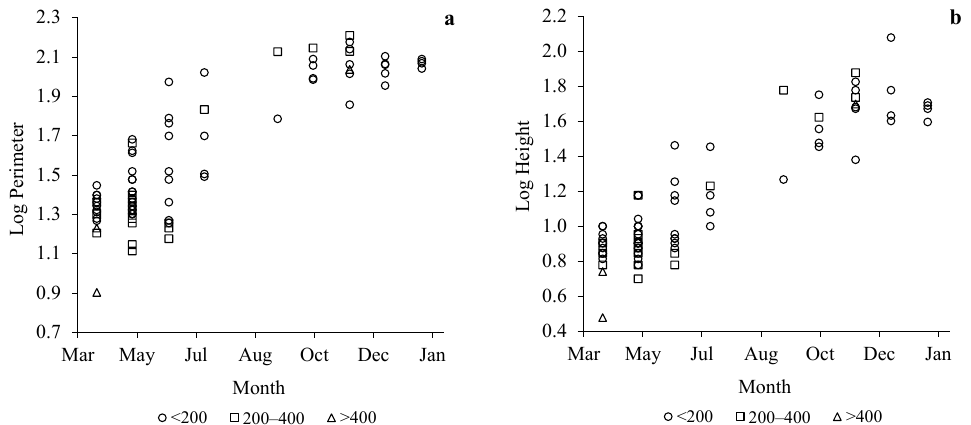
Figure 3. Variations in log perimeter ( a ) and log height ( b ) of nests collected per month classified according to altitudinal range (<200, 200–400, >400).